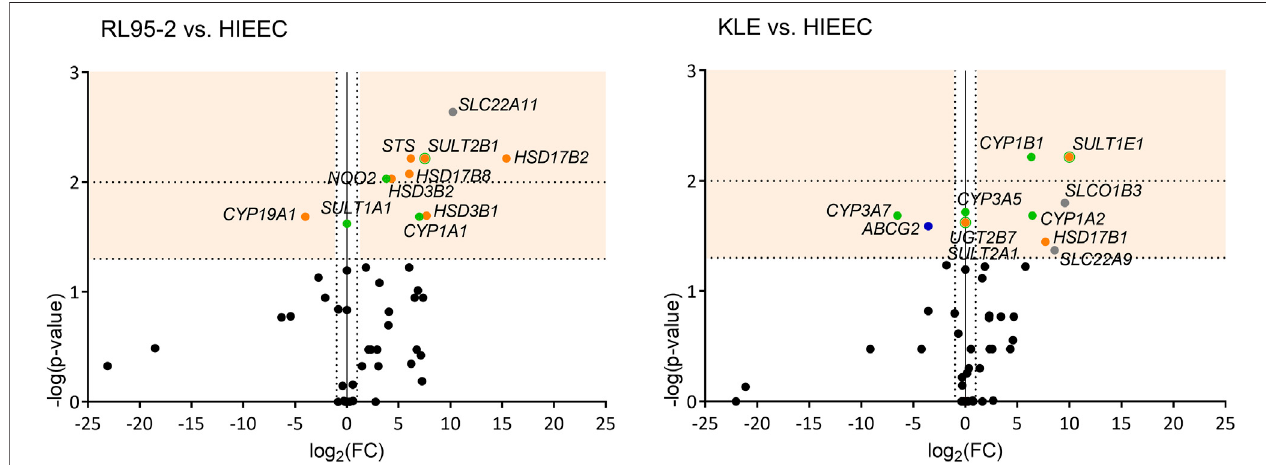
FIGURE2| VolcanoplotsofgenesdifferentiallyexpressedineachofRL95-2andKLEcells vs HIEECcells.Geneswithsigni fi cantchangesinexpressionareshown in different colors according to function: uptake of steroid precursors, gray; ef fl ux of steroid precursors, dark blue; estradiol biosynthesis, orange; phase I and II metabolism, green. See legend to Figure 1 for further